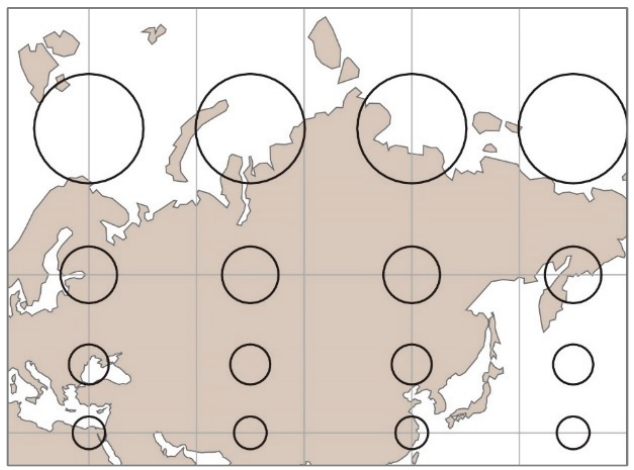
Figure 8. Russia as on the Mercator projection with Tissot indicatrix.